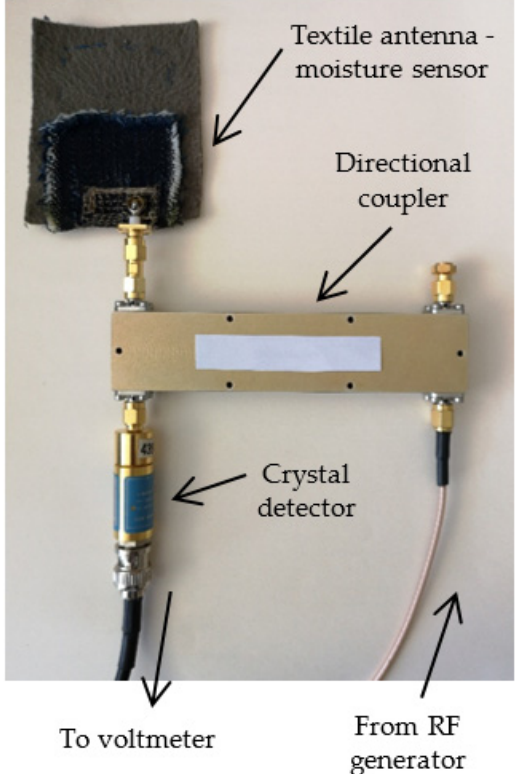
Figure 19. Experimental verification of reflection measurement mode setup.